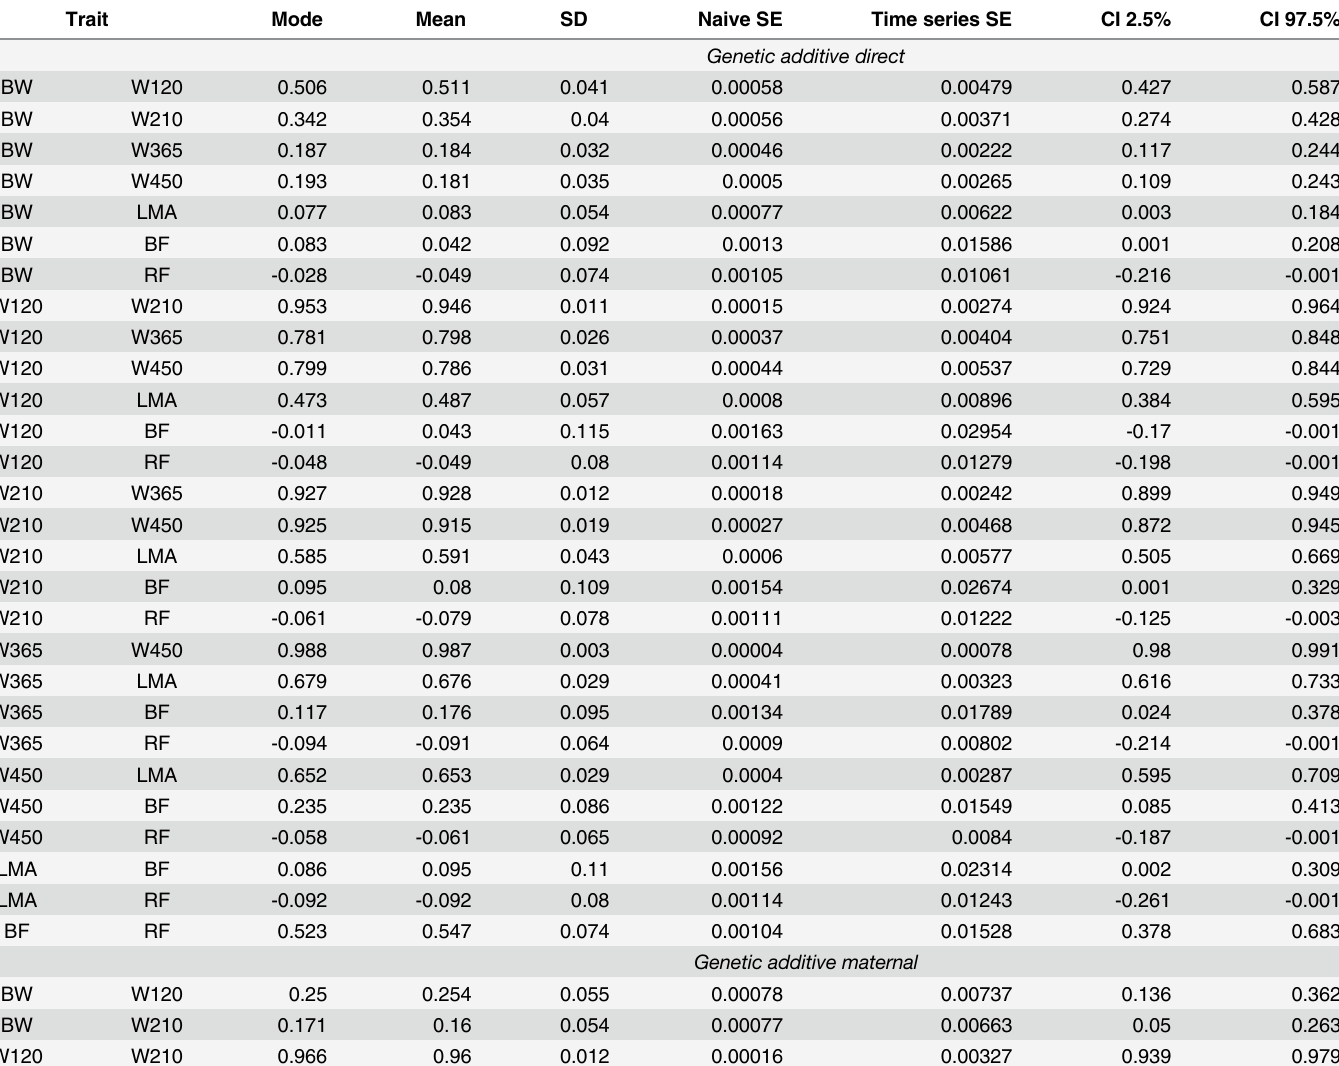
Table 6. Marginal posterior distributions of the genetic correlation among the growth and carcass traits in Polled Nellore cattle.